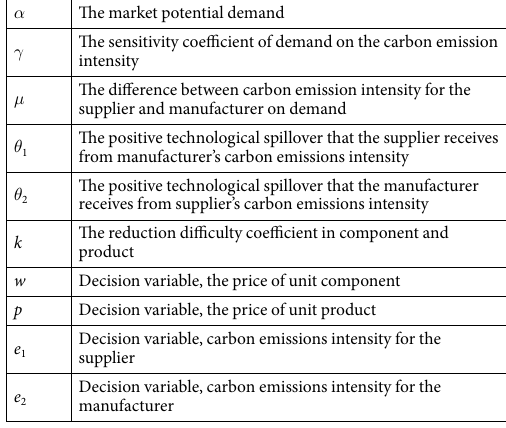
Table 1. Definitions of coefficients.